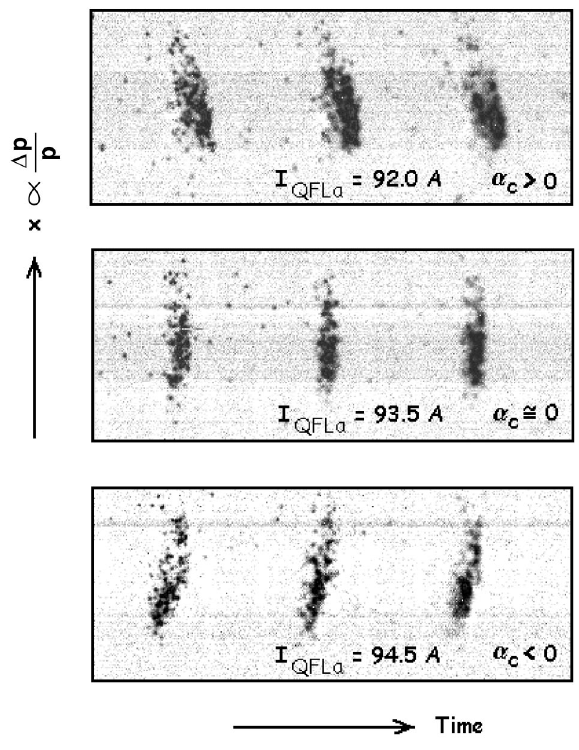
FIG. 17. Transition from positive to negative momentum seen on streak camera images for differ- compaction factor (cid:20) c ent settings of one quadrupole family. The images are taken during the tenth turn at a location with nonzero dispersion. The horizontal position x is dependent on the energy, so the time- momentum correlation becomes